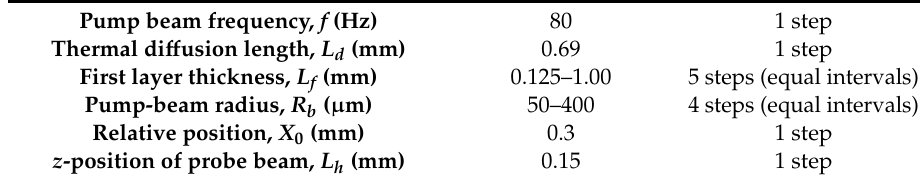
Table 3. Study Table 3. Study parameters.